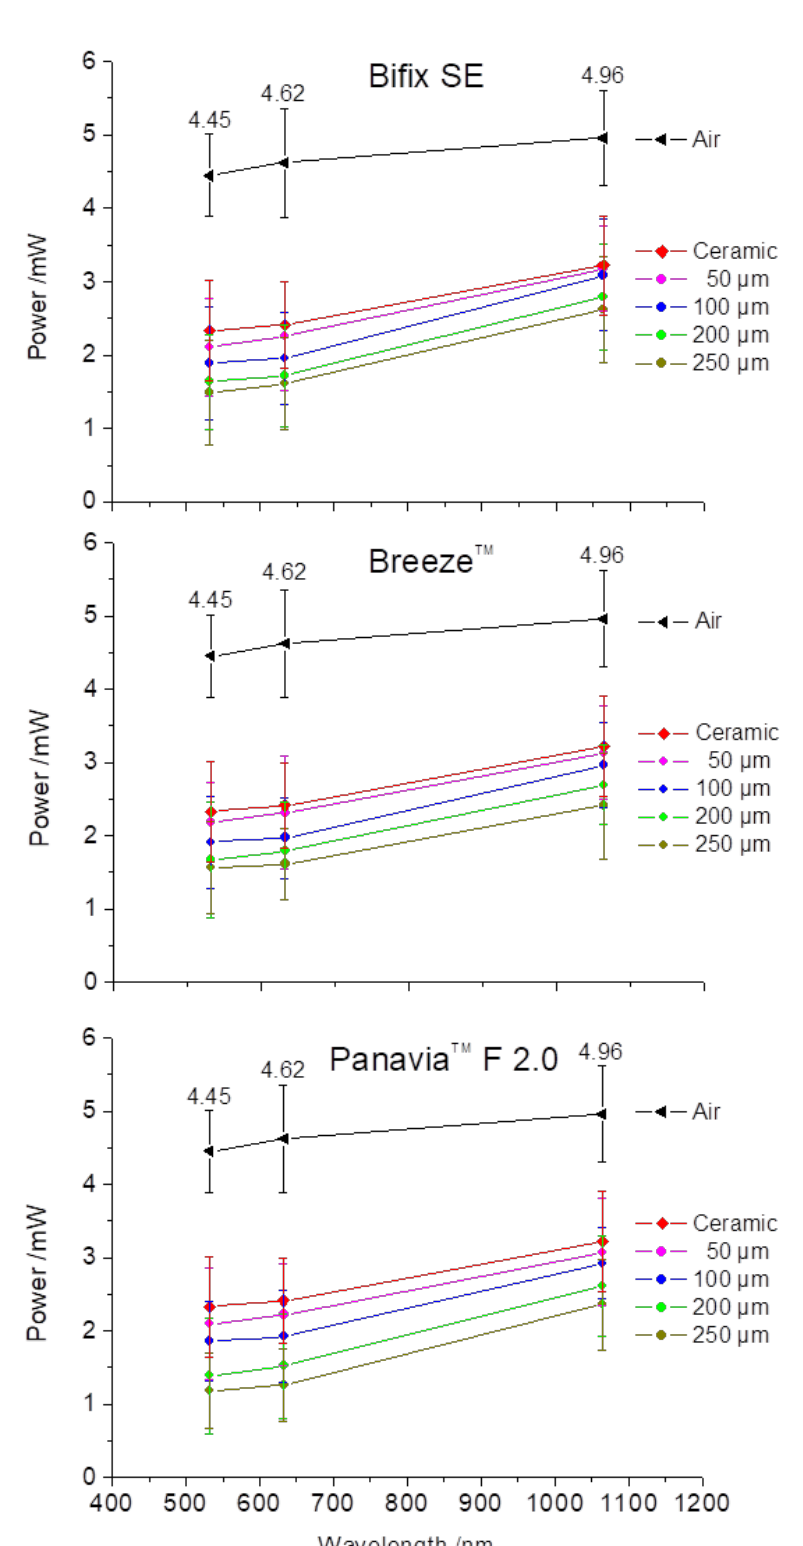
Figure 4. Influence of the layer thickness of the examined cements on the transmitted powers for the wavelengths 532, 632.8, and 1064 nm. For direct comparison, the adapted laser powers in air (black curve) as well as the transmitted powers of all the lasers through the ceramic base model (red curve) are shown. Table 1. Transmitted power values as a function of material, layer thickness, and wavelength. Δ mW specifies the difference in values of the transmitted powers among the corresponding wavelengths, thus giving information about their increase.